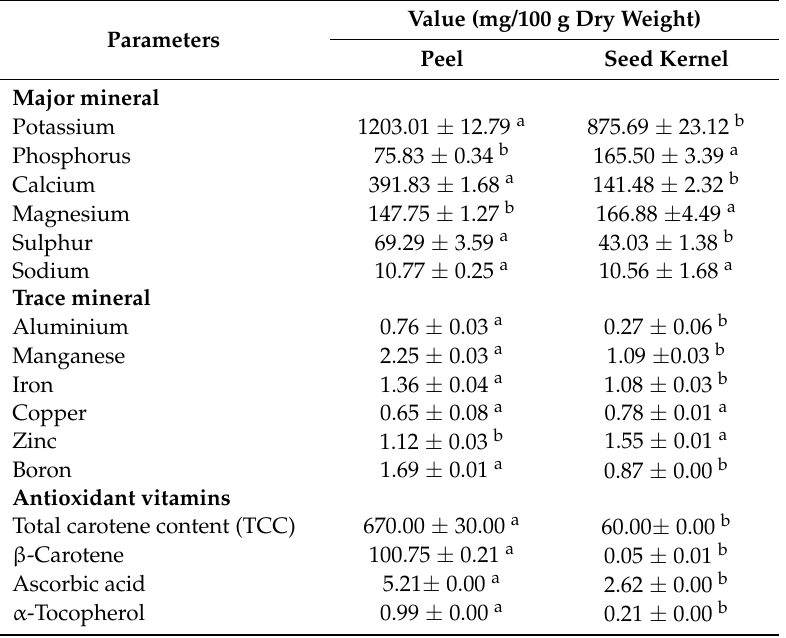
Table 2. Mineral Elements and Antioxidant Vitamins of M. odorata peel and seed